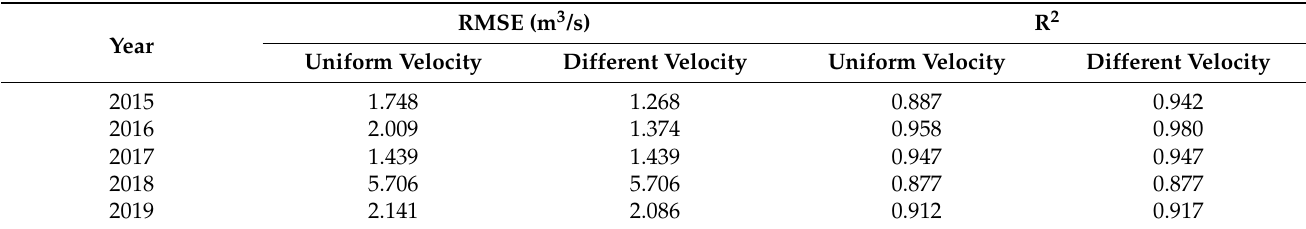
Table 4. Comparison of the uniform velocity case and the different velocity case by the root mean square error (RMSE) and the coefficient of determination (R 2 ) estimated by comparing the simulated runoff hydrographs to the observed.